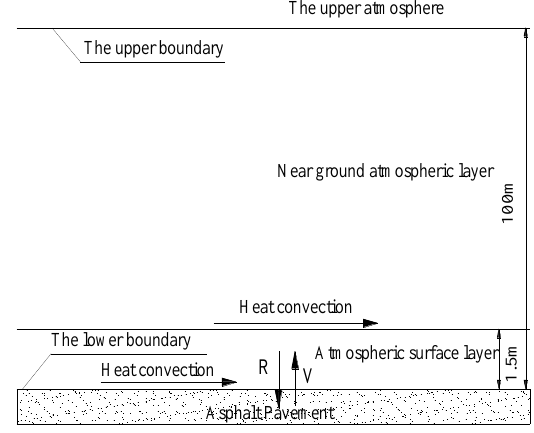
Figure 7. The sketch of the simulation of the atmospheric layer.